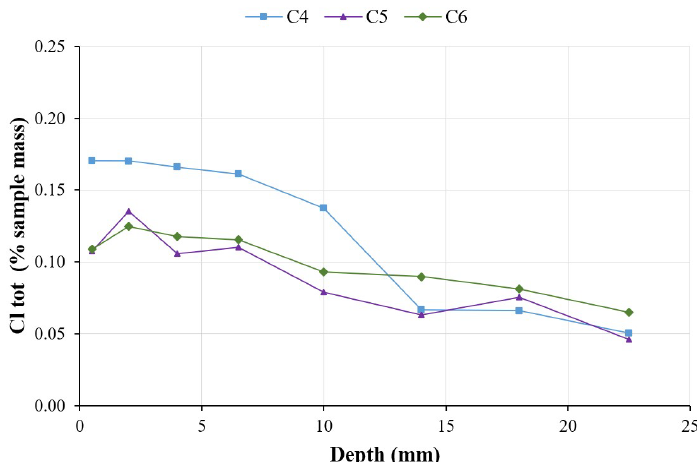
Figure 9. Chloride content as function of the depth from the exposed surface.